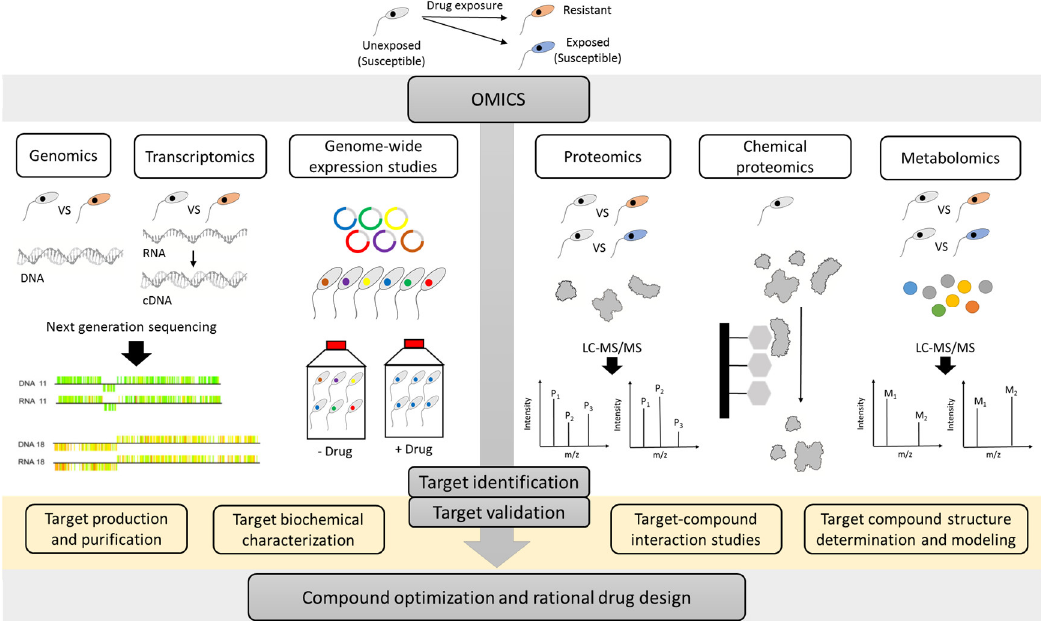
Figure 1. An overview of the multiple omics strategies that can be used to unravel the target of an anti-kinetoplastid compounds. Resistant parasites can be experimentally selected in the laboratory or obtained from the field. Comparative genomics, transcriptomics, proteomics / metabolomics approaches, genome-wide cosmid/RNAi libraries, and chemical proteomics can contribute complementary insights in the mode-of-action (MoA) or mode-of-resistance (MoR). Application of the various omics methodologies can enable the identification of drug targets, which may serve as starting point for additional hit finding, lead optimization and rational drug design. M: metabolite and P: protein. A graphical item in the figure about next generation sequencing was adopted from another publication [23].